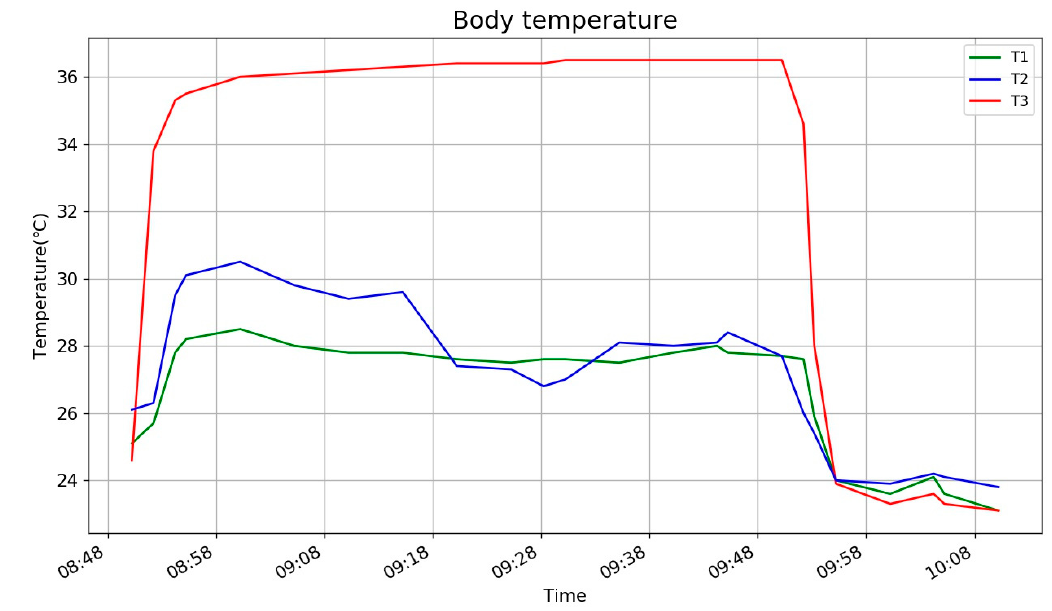
Figure 11. Measurement of Real Body Temperature.